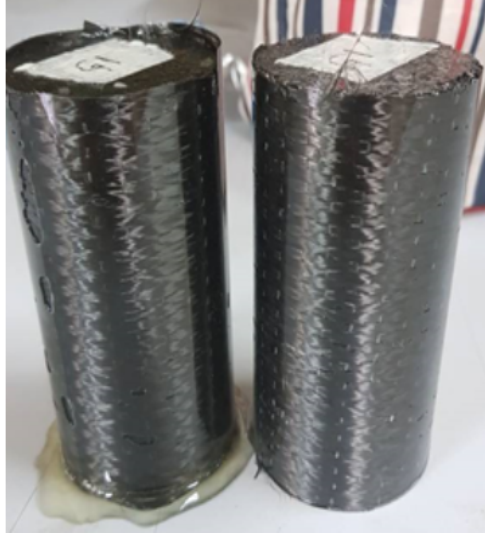
Figure 1: An outlook of confined